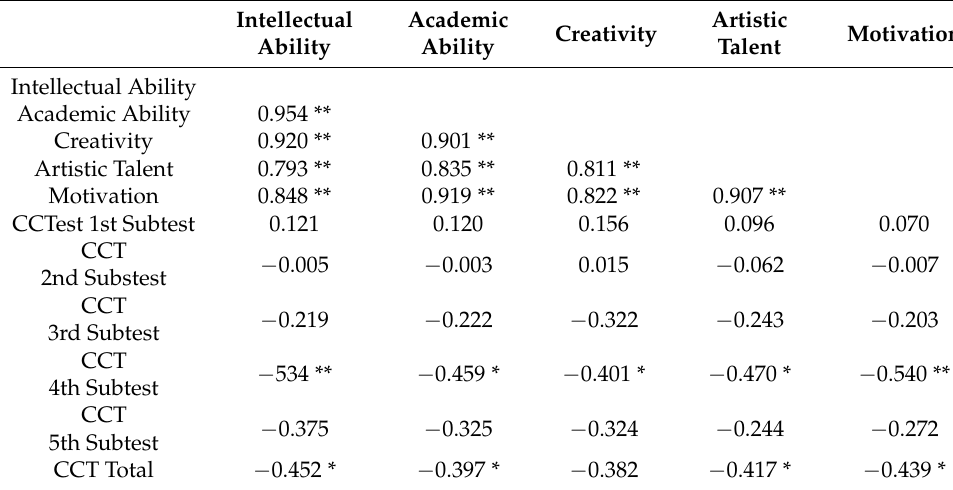
Table 8. Correlations between GRS-P and